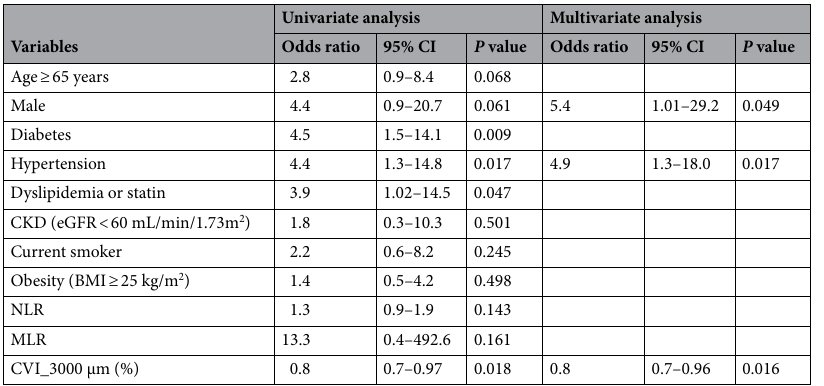
Table 3. Univariate and multivariate logistic regression analyses for factors associated with triple vessel disease. BMI body mass index, CKD chronic kidney disease, CVI choroidal vascularity index, eGFR estimated